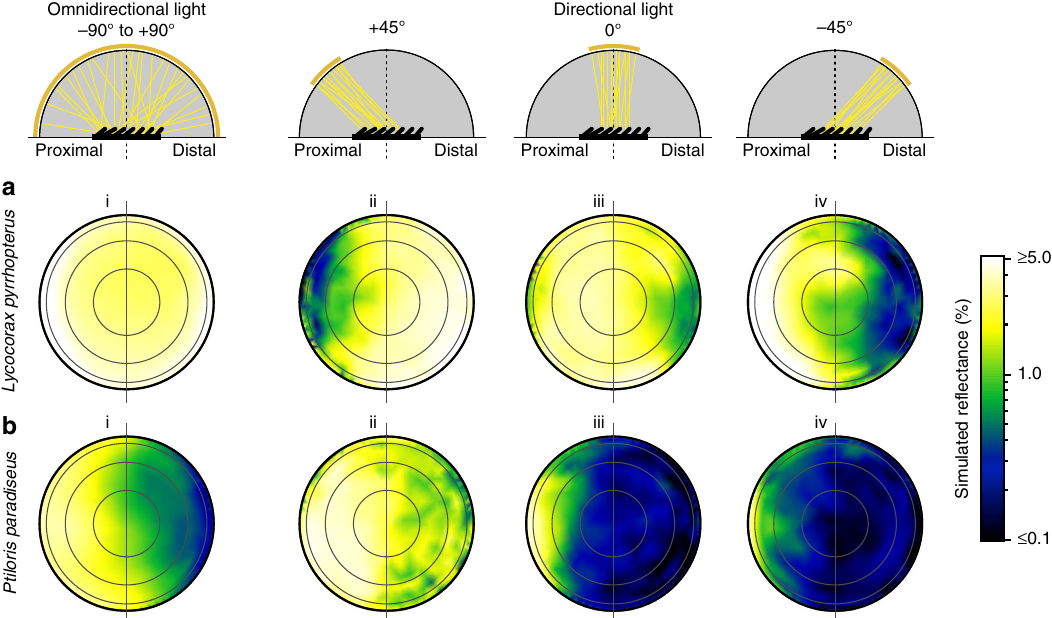
Fig. 5 The impact of viewing direction and illumination on the appearance of feathers. a Normal black Lycocorax back feather. b Super black Ptiloris breast feather with modi fi ed barbule arrays. Directional re fl ectance from ray-tracing simulations is plotted as a log-scale color gradient on orthogonal projections of the re fl ectance hemisphere under four different lighting conditions (i – iv). Concentric rings represent 22.5 ˚ , 45 ˚ , 67.5 ˚ , and 90 ˚ . Horizontal line separates proximal and distal viewing quadrants. Schematics show a cross-sectional view of the optical setup of each illumination. Re fl ectance hemisphere in gray, feather in black. Concentric gold band indicates the angle of light source, yellow lines show the path of incident light (subsequent path of re fl ected light not shown). For normal black Lycocorax , the darkest viewing quadrant varies with the direction of incident light (compare ii with iv), whereas super black Ptiloris shows a strong directional bias in which the distal viewing quadrant is the darkest under all lighting conditions. See Supplementary Fig. 9 for additional feather swatch were also scaled at 11% to ensure that the size of the solid angle illuminating the plumage patch in the simulations matched that in the spectrophotometry measurements. One million rays of random wavelength between 300 and 700nm were positioned on a grid spanning the light source. A circular aperture was used to cull rays from the square source, thereby shaping the source to match that of the spectrophotometer probe. Ultimately, 785,398 rays were emitted by the circular source in random directions within an angular range of 28 ˚ , thereby illuminating the 330- µ m-diameter spot centered on the feather. In both “ omni-directional ” and “ directional ” simulations, each ray had one of three possible fates. (1) No interaction, where the ray passes through gaps in the feather vane without ever striking the surface of the feather and ultimately terminates when it intersects the transmittance hemisphere. (2) “ Transmitted, ” where the ray strikes the surface of the feather one or more times until it ultimately exits the underside or reverse surface of the feather vane and terminates on the transmittance hemisphere. (3) “ Re fl ected, ” where the ray strikes the surface of the feather one or more times until it ultimately exits the topside or obverse surface of the feather vane and terminates on the re fl ectance hemisphere. For the scope of this study, we only consider the subset of incident rays that are “ re fl ected ” (fate 3). Rays that terminate on the transmittance hemisphere (fates 1 and 2), represent more complex interactions between multiple overlapping feathers in the plumage and/or the skin that we do not consider here. We simpli fi ed the ray-tracing simulations of the feather surface and controlled for potential differences in surface roughness between the real feathers by excluding surface scattering caused by surface roughness (re fl ections in nonspecular directions) from the simulation. We traced rays using the surface normals of the bare polygon mesh of the feather, treating each polygon in the mesh as a smooth surface. Since no BRDF model was applied to the surface, all radiant power was directed in the specular direction. Thus, each time a ray struck the surface of the feather (a simpli fi ed “ scattering ” event), it bifurcated into one and only one component ray that re fl ected from the surface of the feather, and one and only one component ray that transmitted into the feather. The direction of the re fl ected ray was computed based on the law of re fl ection ( θ i = θ r ), and Fresnel equations yielded the fraction of the incident radiant power re fl ected as a function of the incident angle and the ratio of the index of refraction of air (1.0) and feather keratin (1.56). To investigate the effects of surface microstructure independent of any potential differences in melanin or internal nanostructure between the real feathers, we assumed that rays transmitted into the feather were entirely absorbed before exiting the feather. Thus, any difference in calculated absorption between simulated feathers is caused by variations in the orientation of the feather surface and differences in the number of multiple scattering events.